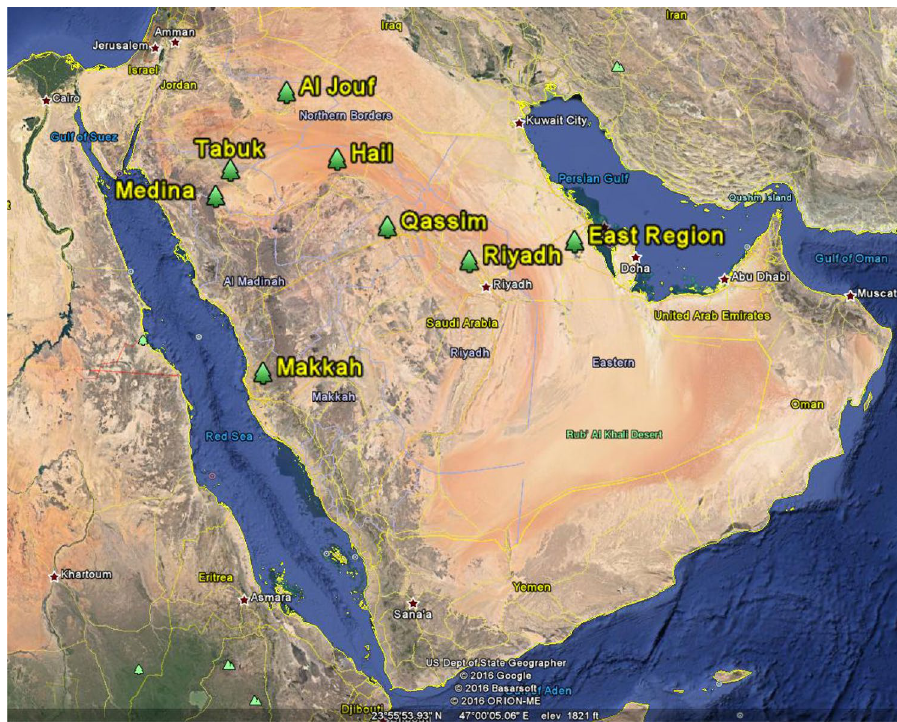
Fig. 1 Location of date palm fields in eight different regions of Saudi